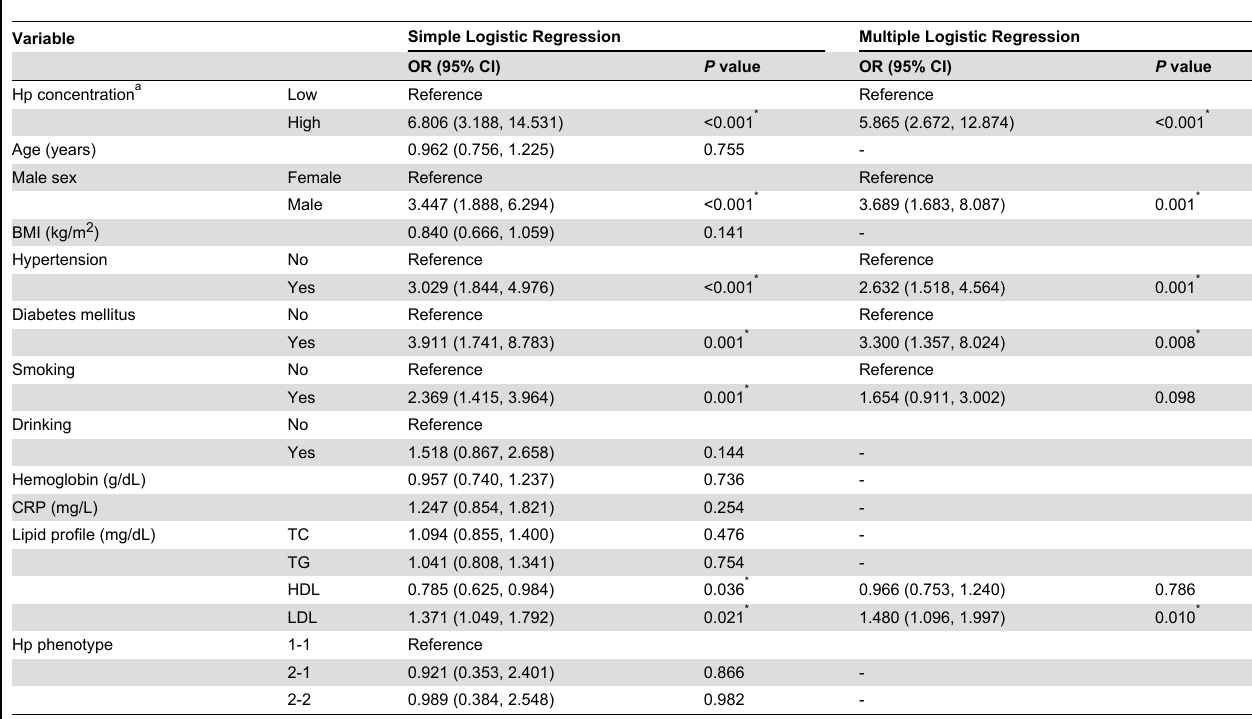
Table 3. Factors associated with coronary artery disease: Simple and multiple logistic regression analyses.